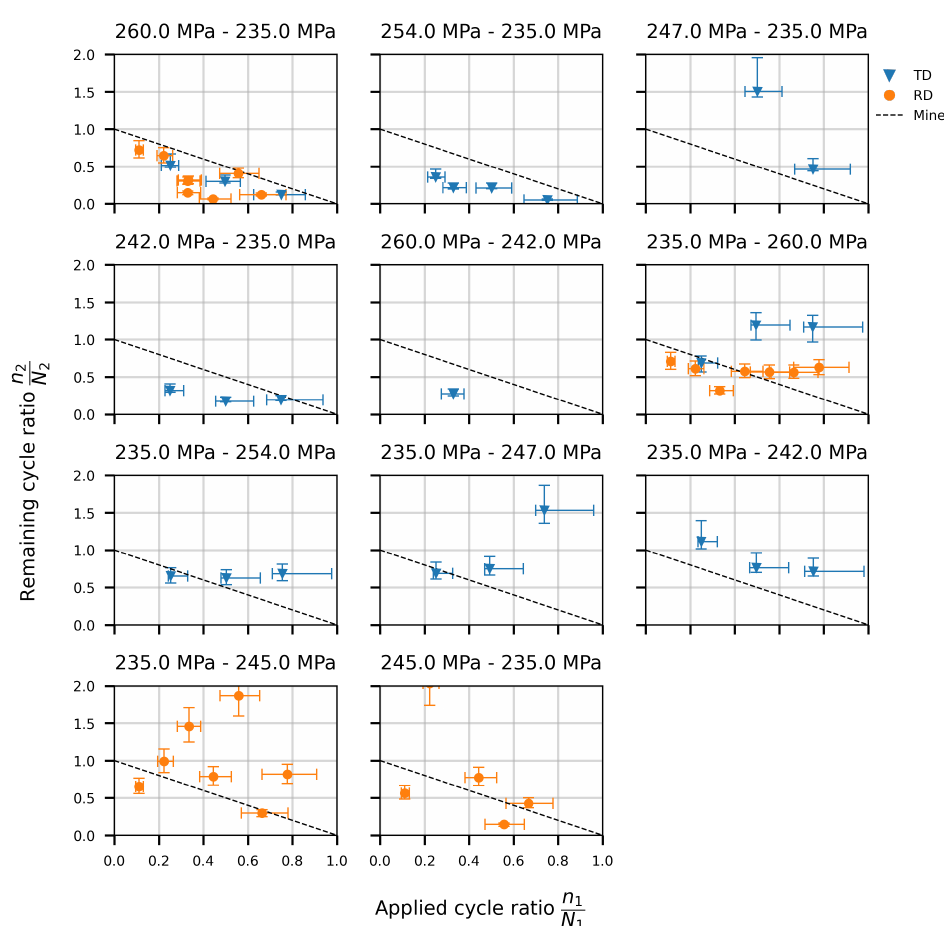
Figure 8. Comparison between the experimental two-level block loading data and Palmgren–Miner’s rule (dashed line), accounting for scatter on the fatigue life by considering the upper and lower bound 95% confidence interval S-N curves. A distinction is made between specimens extracted from the transverse (TD) and rolling direction